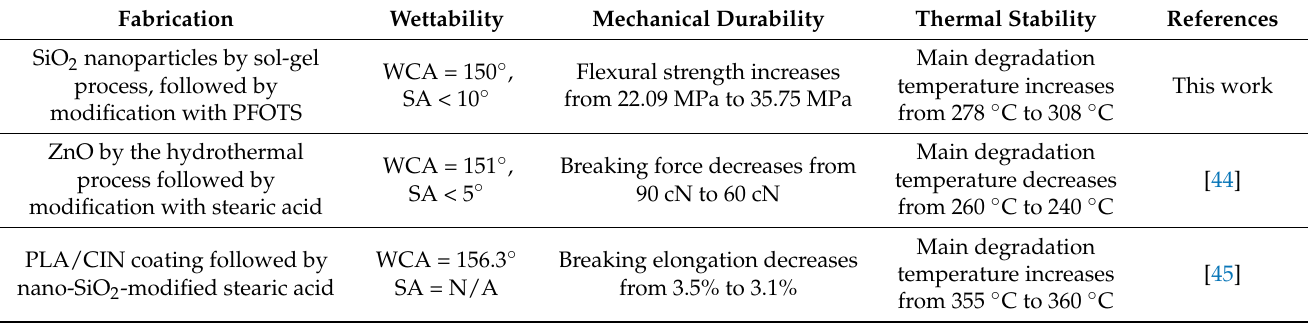
Table 1. Performance of reported superhydrophobic natural fibre surface fabricated via different